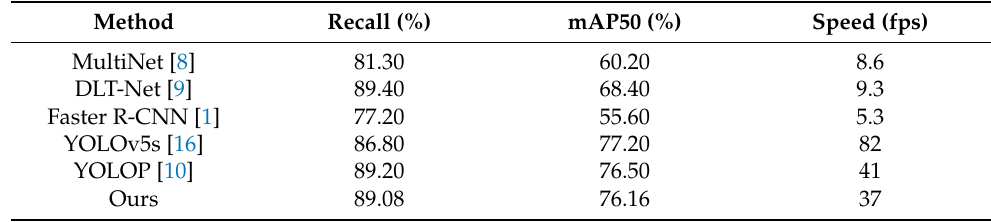
Table 3. Traffic object detection results on the BDD100K